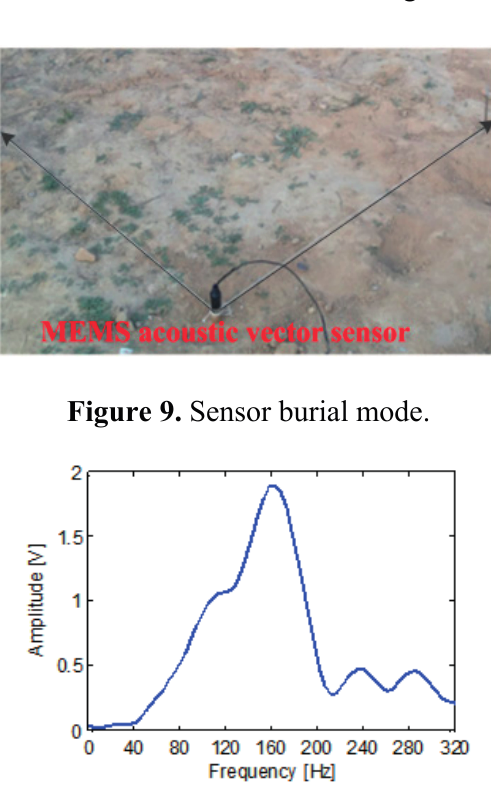
Figure 10. The spectral analysis of the knocking